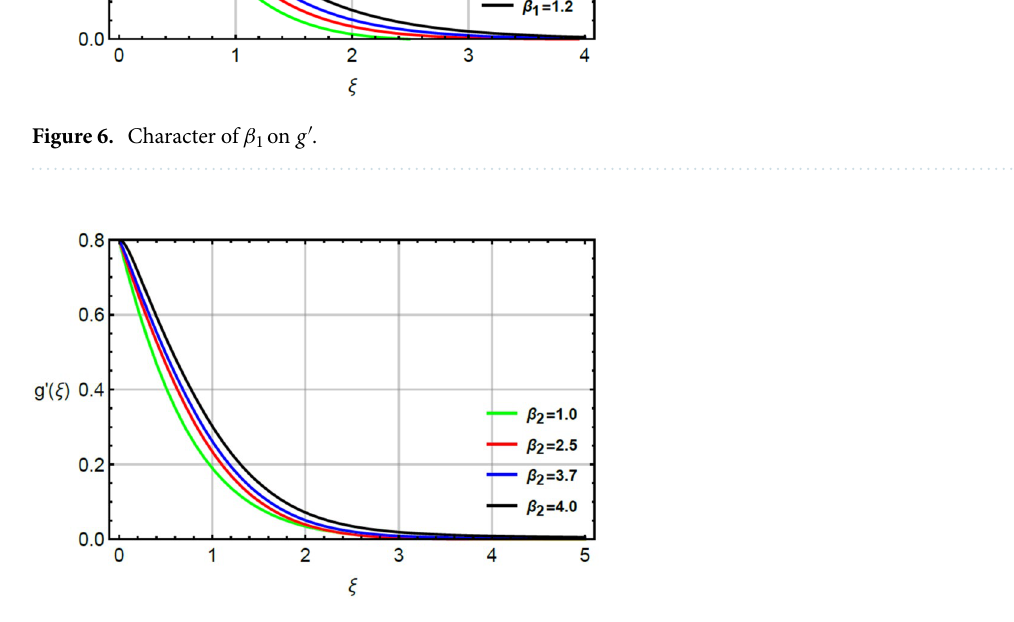
Figure 7. Character of β 2 on g ′